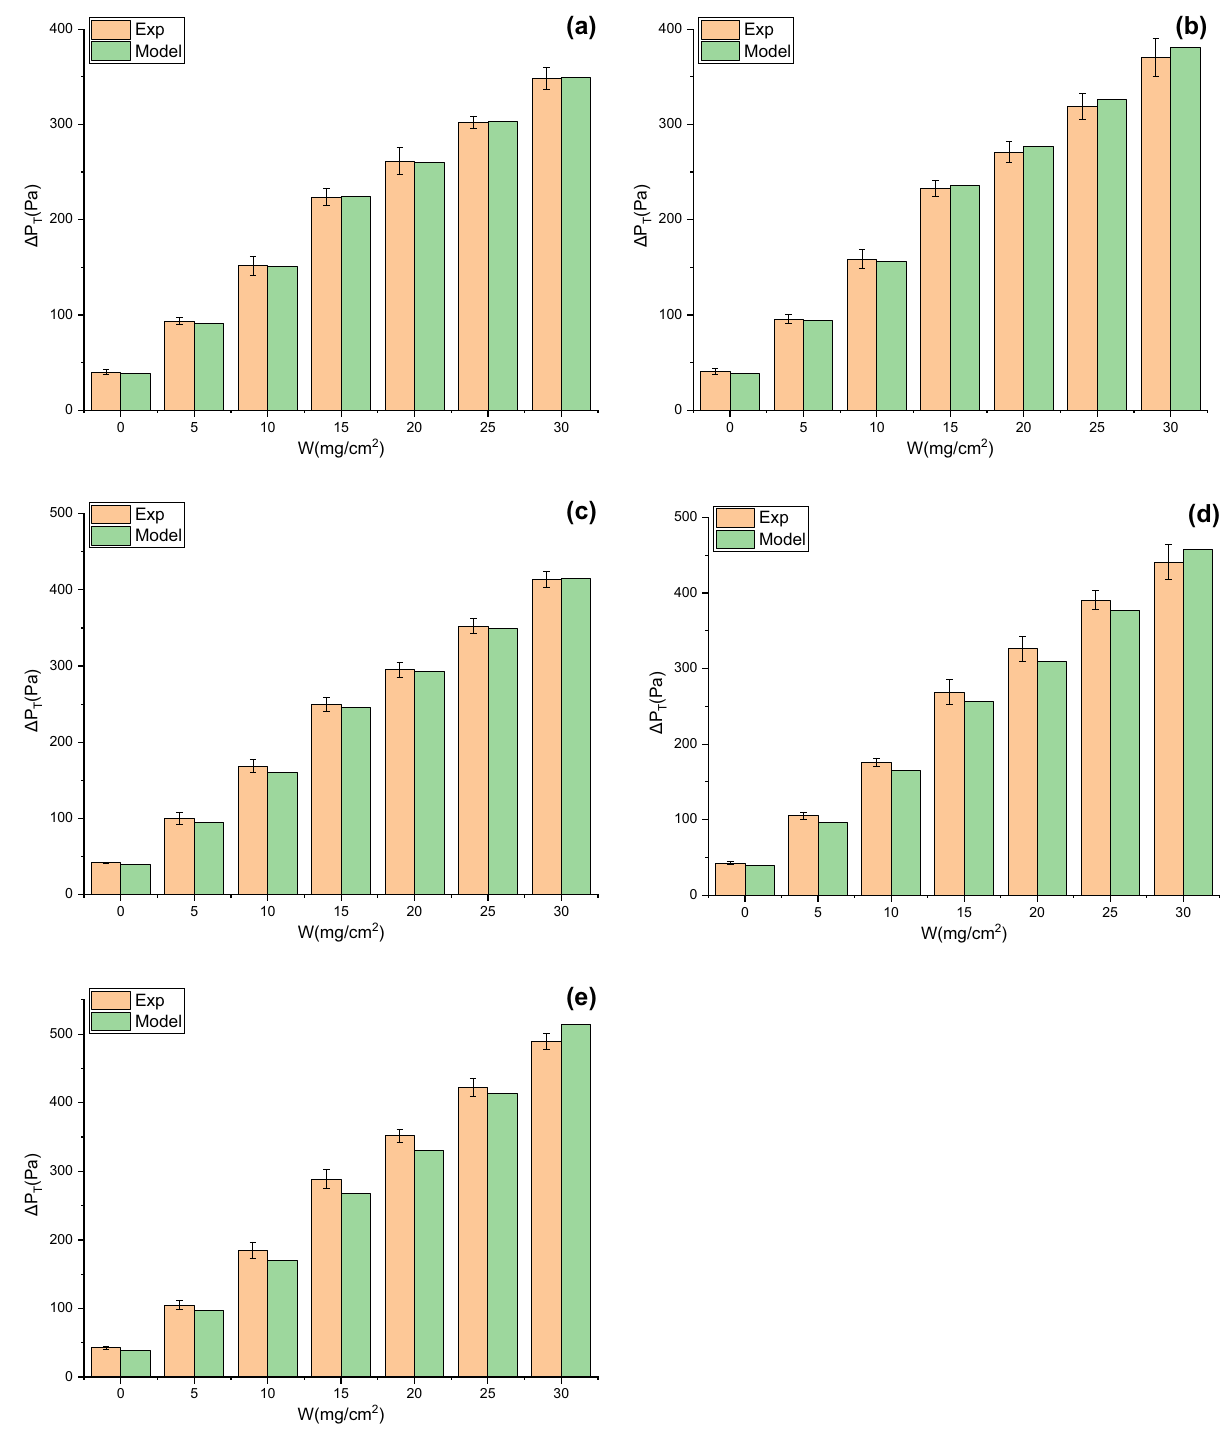
Figure 14. Changes in experimental and modeling total pressure drops with W for V-shaped filter ( a ) α = 0.71, ( b ) α = 1.43, ( c ) α = 2.14, ( d ) α = 2.86, (e ) α =